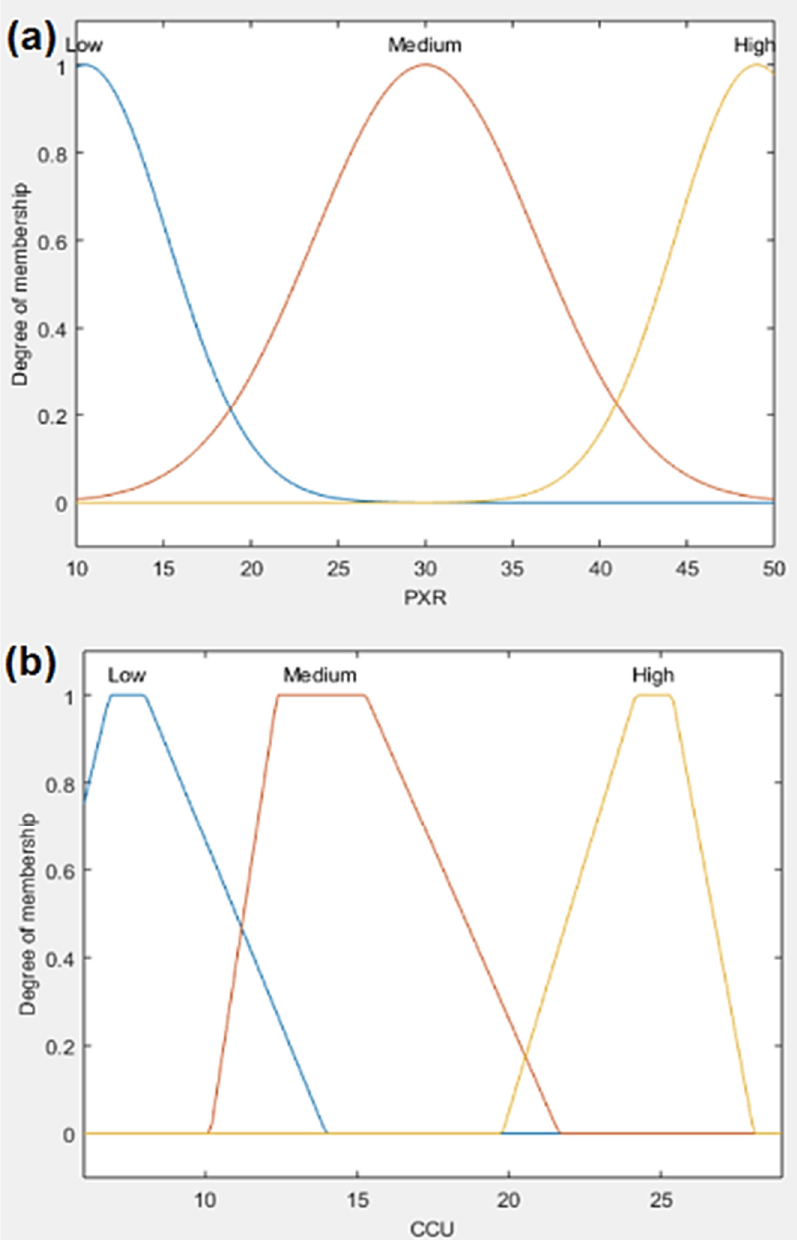
Figure 4. Example of defining the parameters of membership functions in the PMM: ( a ) collector consumption at rougher flotation circuit (PXR); ( b ) copper content in final concentrate (CCU).